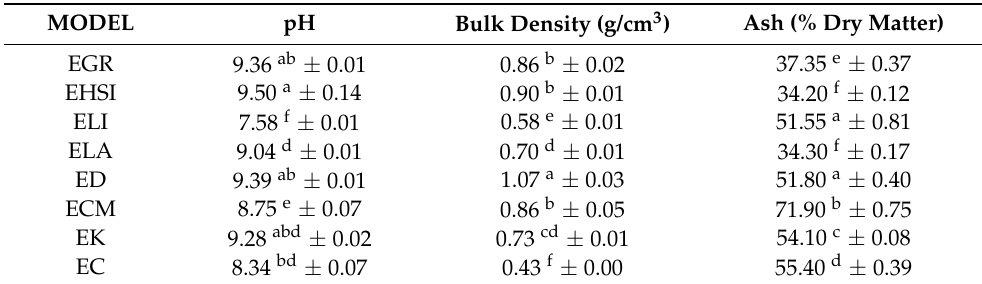
Table 2. Physiochemical characteristics of tested